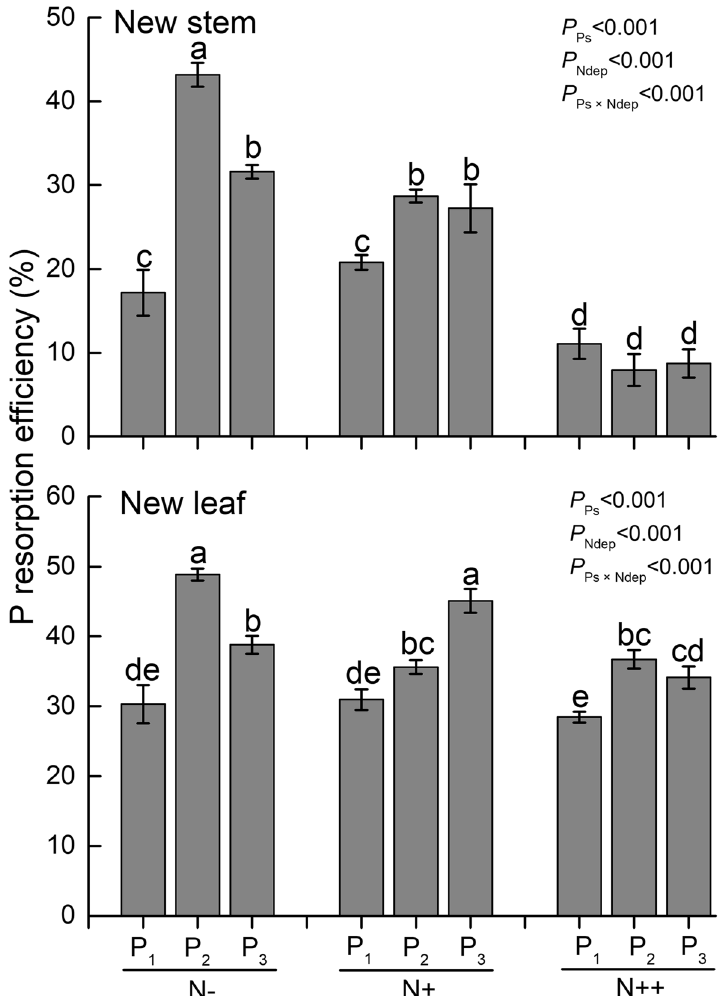
Fig. 4 P resorption efficiency in new stem and new leaf of P. edulis seedlings in response to experimental N deposition rate under different soil P availability. Different lowercase letters indicate significant differences among different treatments (Tukey’s HSD, α standard error from the mean at each sampling ( n =